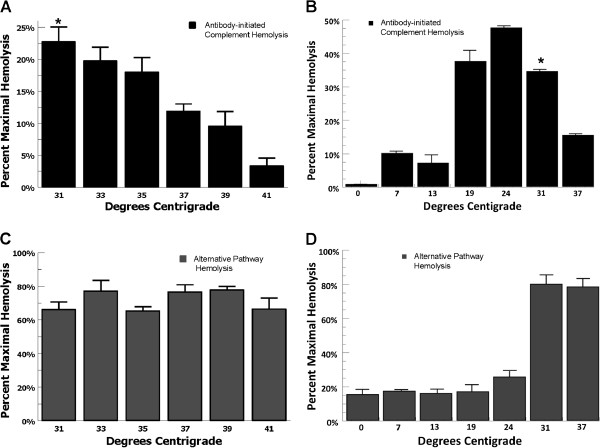
Functional hemolytic assays of complement activation. (A) CH50-type antibody-initiated complement assays incubating antibody-sensitized erythrocytes (EA) with 0.2% human serum for 1 hour at 31-41°C showed that hemolysis of antibody-sensitized erythrocytes in human serum differed significantly as a function of temperature (ANOVA P < 0.01). There is 2-fold more hemolysis at 31°C vs. 37°C (*t-test P = 0.01) (P ≤ 0.05 for the comparisons 31 vs. 37, 31 vs. 39, 31 vs. 41, 33 vs. 37, 33 vs. 39, 33 vs. 41, 35 vs. 39, 35 vs. 41, with significantly more hemolysis at lower temperatures) Data are mean ± SEM for 4 independent experiments. (B) Evaluating antibody-initiated complement activation from 0-37°C showed that hemolysis of antibody-sensitized erythrocytes in human serum differed significantly as a function of temperature (ANOVA P < 0.01). There was 2.5-fold more hemolysis at 31°C vs. 37°C (*t-test P = 0.01). (P ≤ 0.05 for the comparisons 31 vs. 37, 24 vs. 37, 19 vs. 37, with significantly more hemolysis at lower temperatures). The trend of increased complement activation was reversed at 13°C. (No statistical difference between hemolysis at 13 vs. 37 or 7 vs. 37). Data are mean ± SEM for 4 independent experiments. (C) AP50-type alternative complement pathway assays, incubating rabbit erythrocytes with 4% human serum in Mg-EGTA-GVBS for 30 minutes at 31-41°C showed that temperature did not influence complement-mediated cell lysis over therapeutic hypothermia temperatures (ANOVA P = 0.45). Data are mean ± SEM for 4 independent experiments. (D) Evaluating alternative pathway activation from 0-37°C showed that alternative pathway activation was significantly inhibited at 24°C and below. There was no difference in the degree of hemolysis at 31°C vs. 37°C) Data are mean ± SEM for 4 independent experiments.